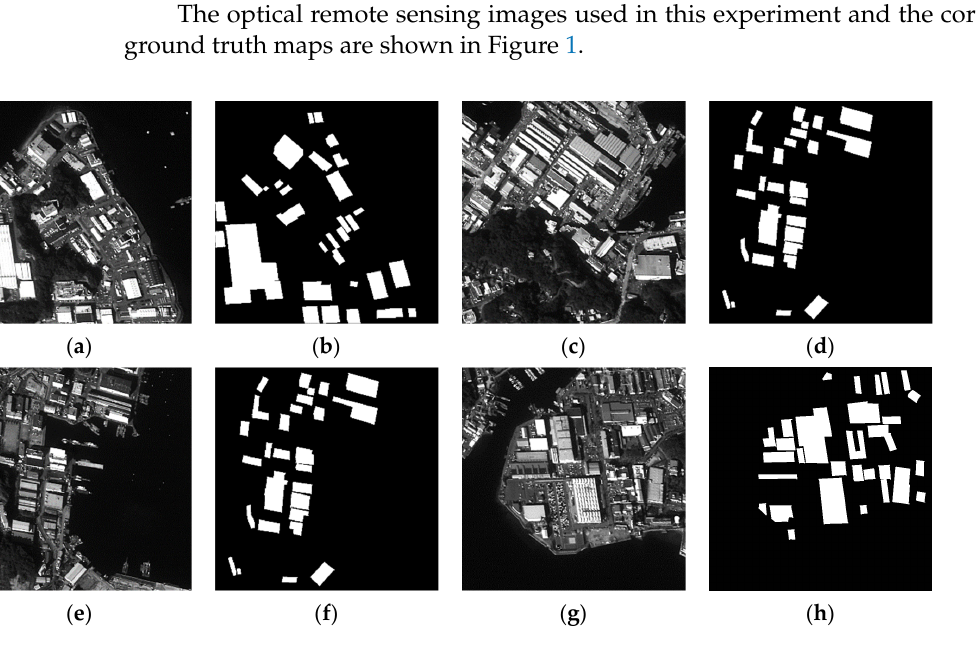
Figure 1. The original experimental images and the corresponding ground truth maps. ( a ) Original image I, ( b ) Ground truth I, ( c ) Original image II, ( d ) Ground truth II, ( e ) Original image III, ( f ) Ground truth III, ( g ) Original image IV, ( h ) Ground truth IV.